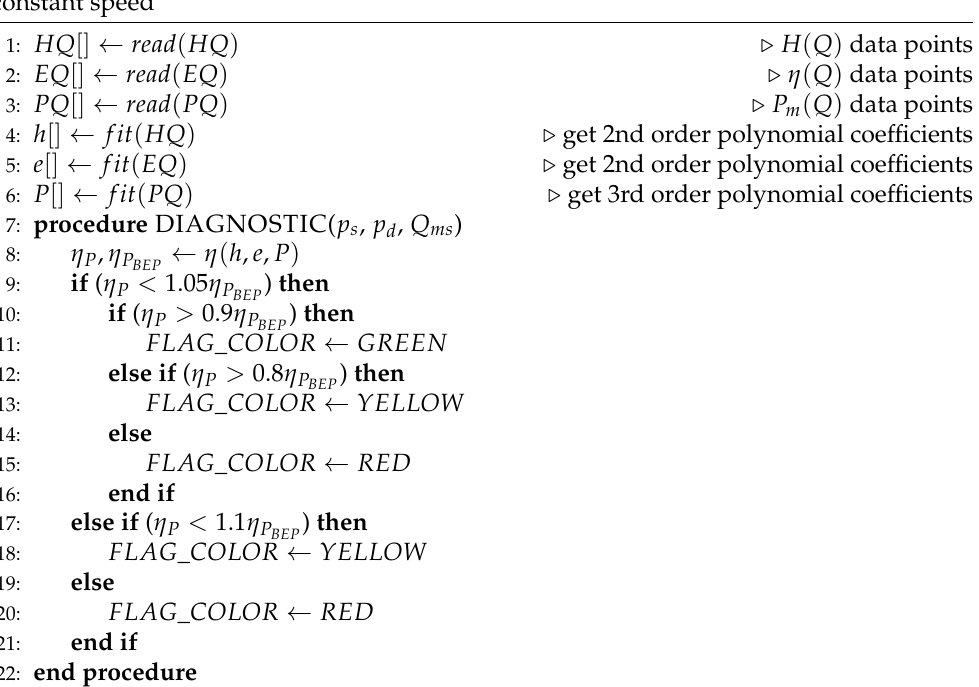
Figure 2. Diagram of the assessment algorithm for hydraulic pump efficiency while operating at constant speed. Algorithm 1 The assessment algorithm for hydraulic pump efficiency while operating at constant